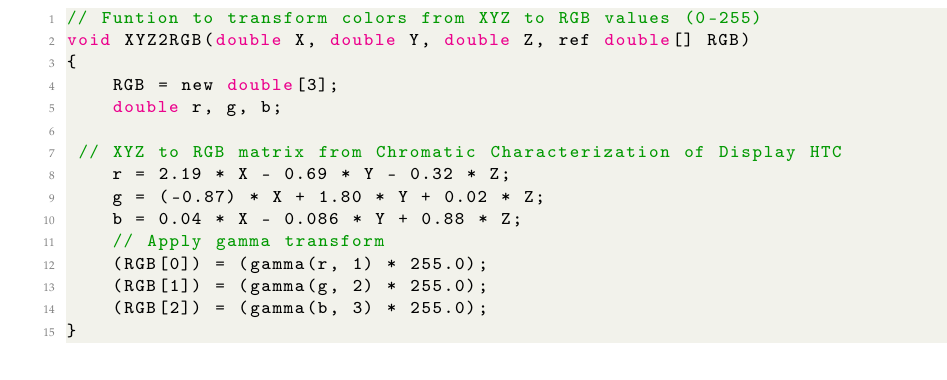
Algorithm 1: Algorithm transformation from XYZ values to RGB